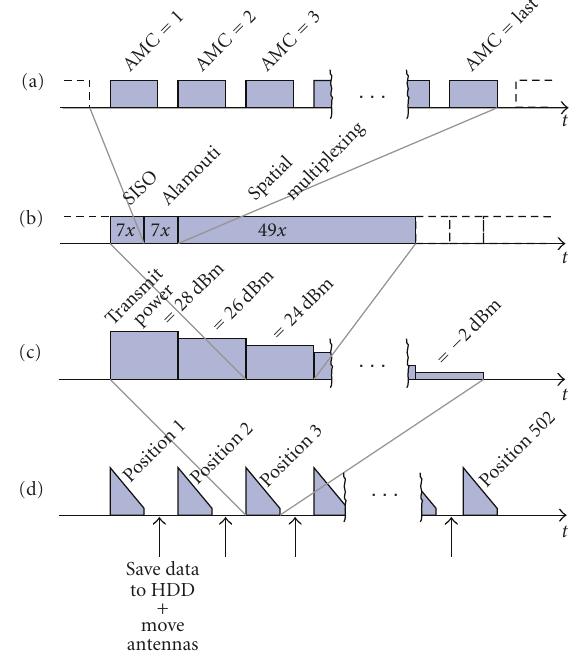
Figure 3: Structure of the transmitted data blocks, (a) is a zoomed version of (b).